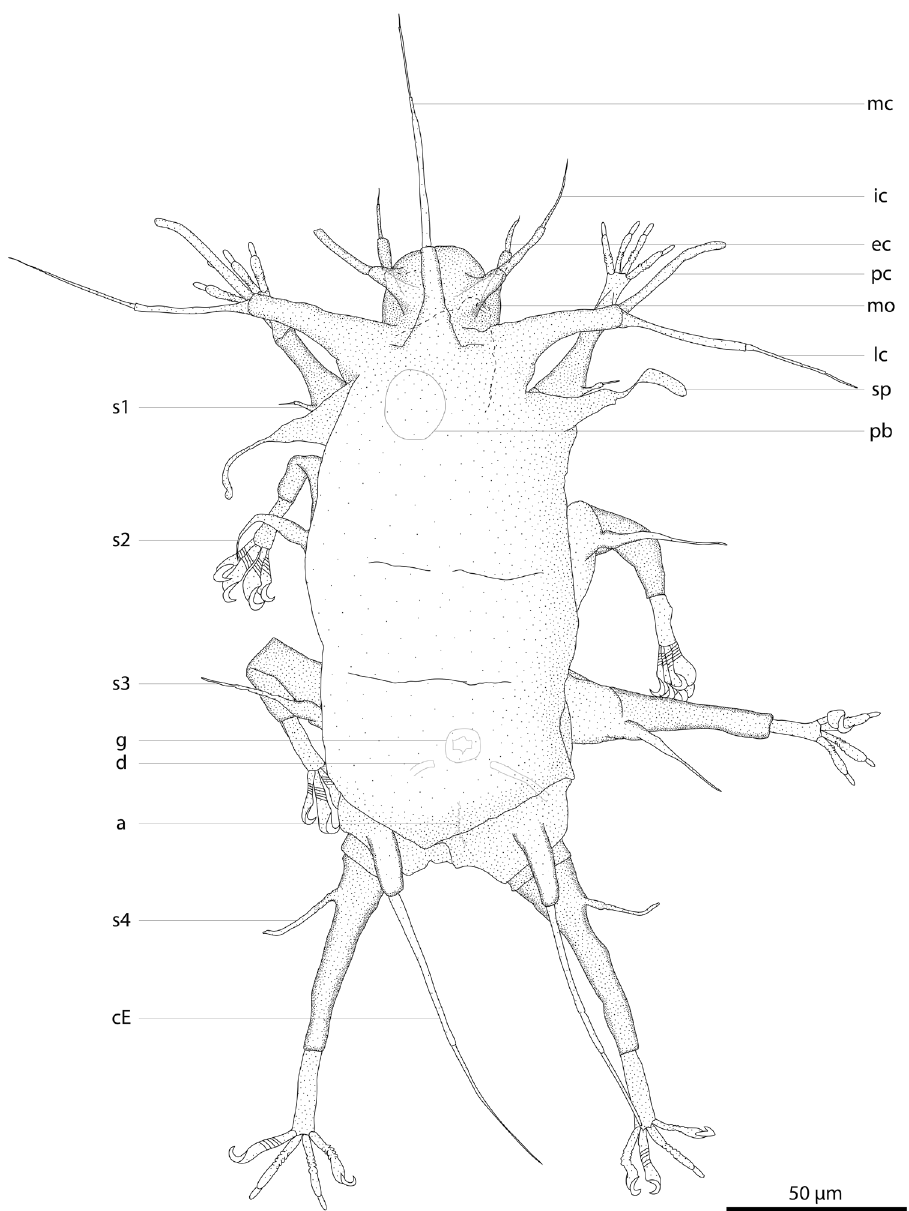
Figure 4. Drawing of Halechiniscus churakaagii sp. n., holotype KUZ Z710 (dorsal view). a anus; cE cirrus E; d seminal receptacle duct; ec external cirrus; g gonopore; ic internal cirrus; lc lateral cirrus; mc median cirrus; mo mouth; pb pharyngeal bulb; pc primary clava; sc scapular process; s1–4 leg I–IV sense